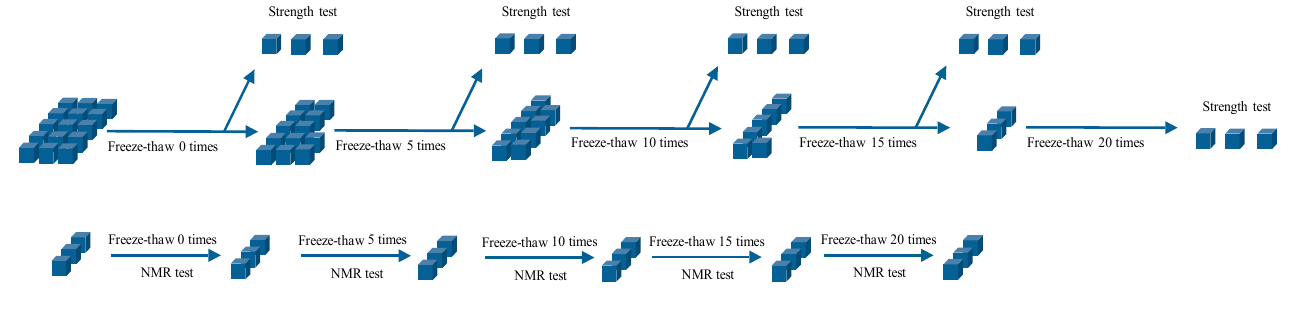
Figure 2. Flow chart of freeze-thaw cycle.